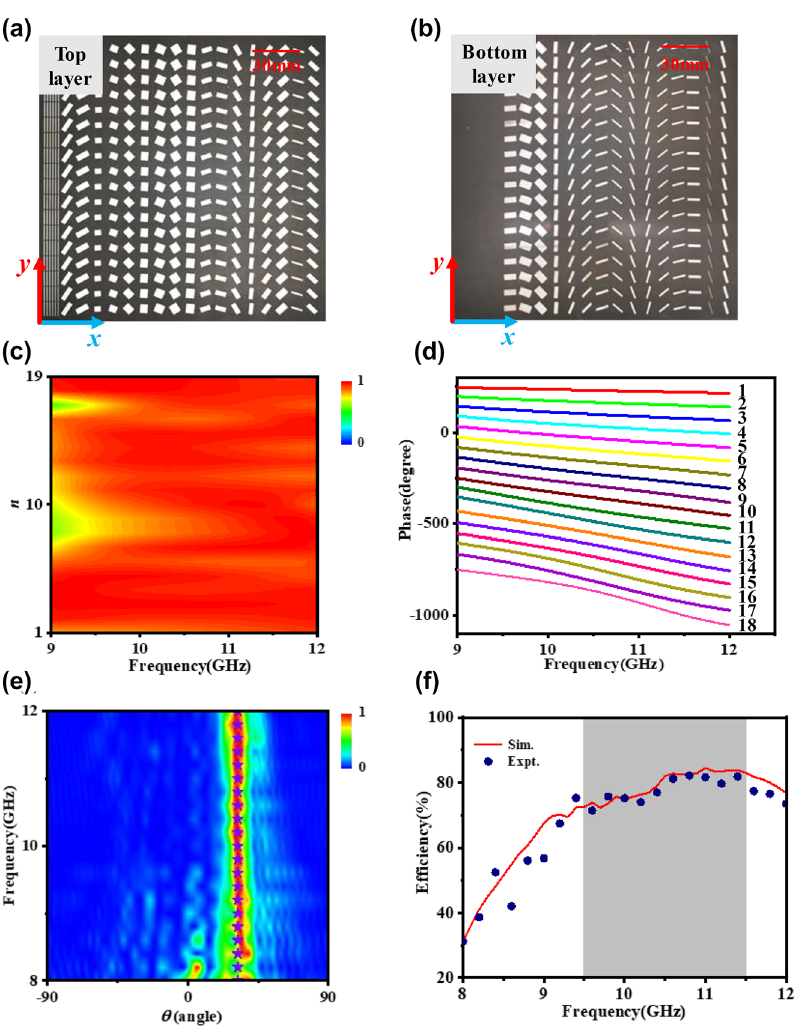
Figure 3: Design of achromatic beam deflector. (a) Top layer and (b) bottom layer of the fabricated achromatic beam deflector. (c) The amplitude spectrum and (d) phase profile of each unit cell from FDTD simulation. (e) Experimental far-field patterns against frequency and detection angles within the operation band. The modena solid star in (e) represents the theoretical value of deflection angle. (f) Simulation and experimental efficiency of the achromatic beam